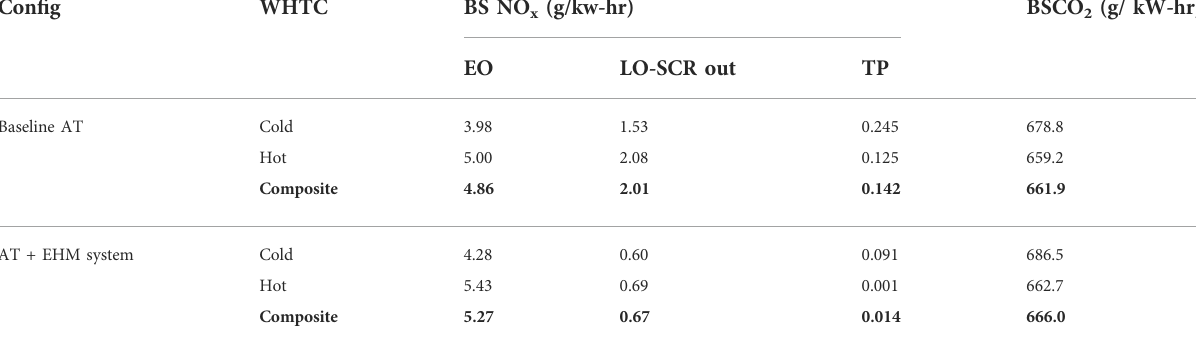
TABLE 13 Test results summary of European Regulatory Test Cycle WHTC. Con fi